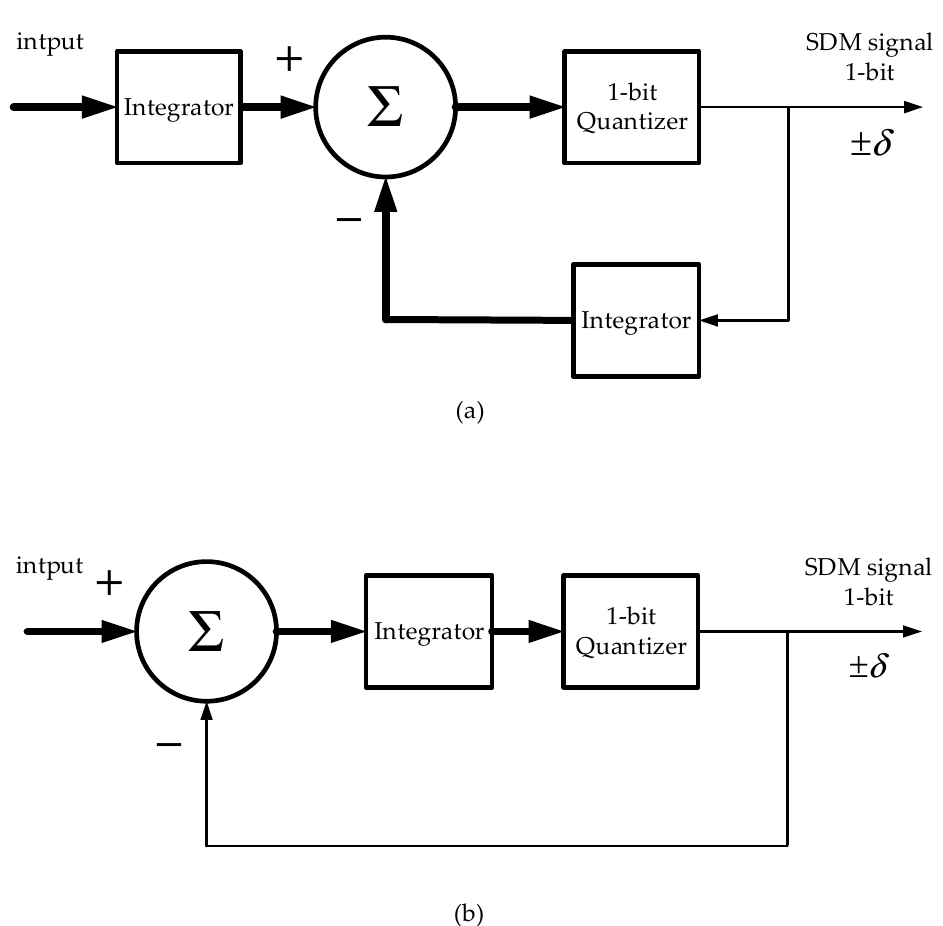
Figure 6. SDM modulator: ( a ) as a DM modulator preceded by an integrator; ( b ) equivalent SDM modulator block dia- gram.